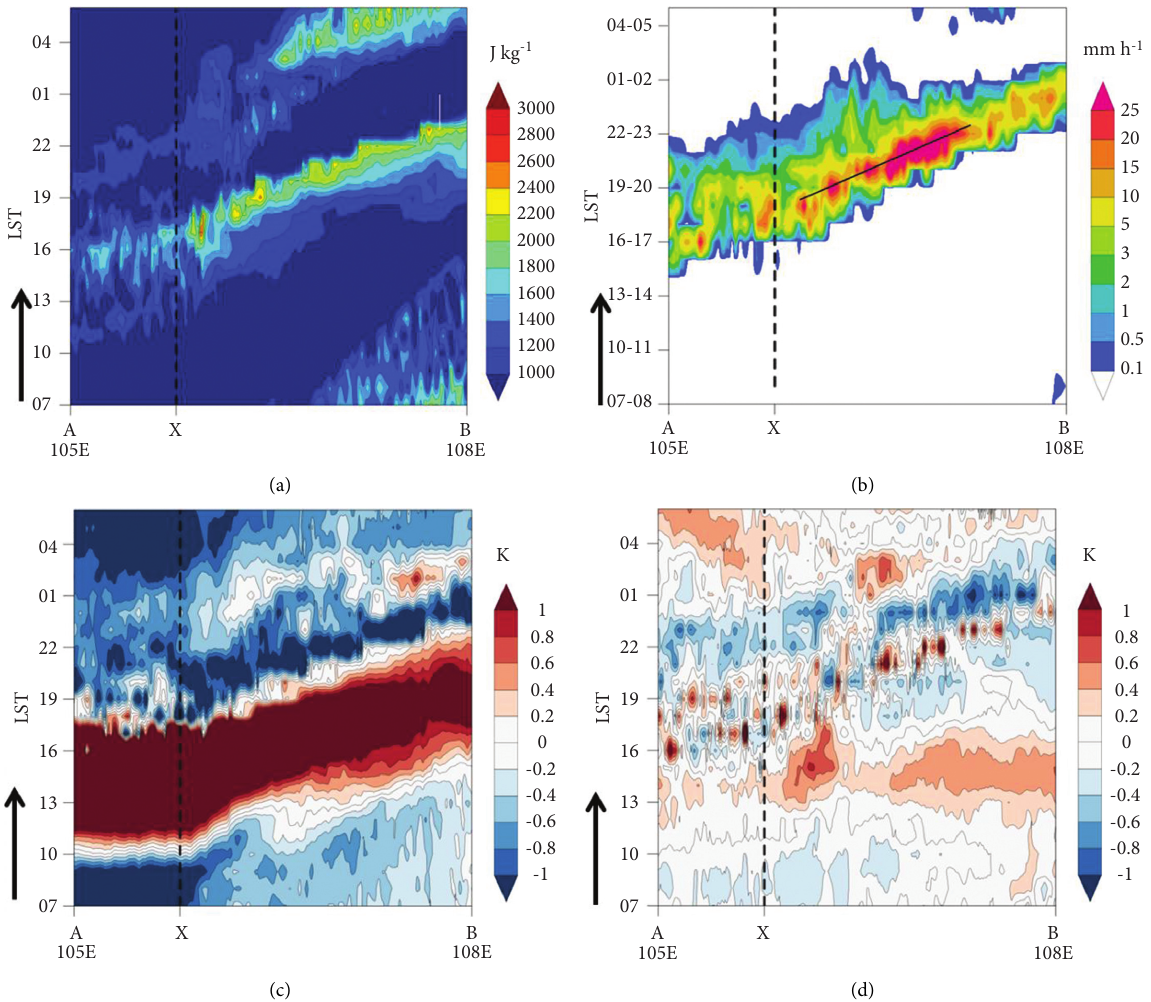
Figure 10: Diurnal cycle on January 1, 2021, for (a) CAPE, (b) rainfall, and temperature perturbations from daily mean, (c) 0.5km, and (d) 3km. Black dashed vertical lines indicate the position of the eastern coastline of South Sumatra. The phase speed of rainfall propagation of the red line is ∼ 8.8m · s − 1